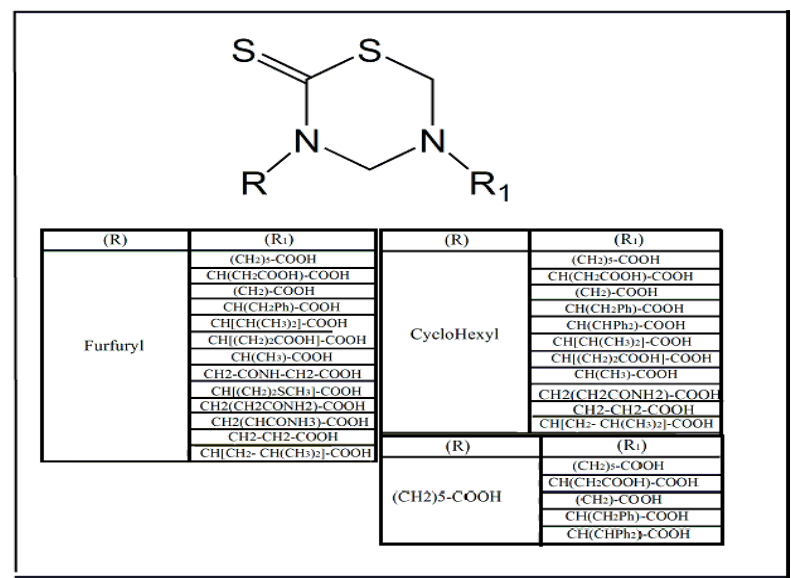
Figure 3. Thiadiazine-based synthetic compounds bound to dithiocarbamates with activity against Trypanosoma cruzi . The different substituents, represented by R1 and R2, may be attached to circular structures formed by thiadiazine and dithiocarbamate. The biological activity of these molecules appears to be related to their ability to inhibit the cysteine protease enzyme and increase oxidative damage in T. cruzi [31].